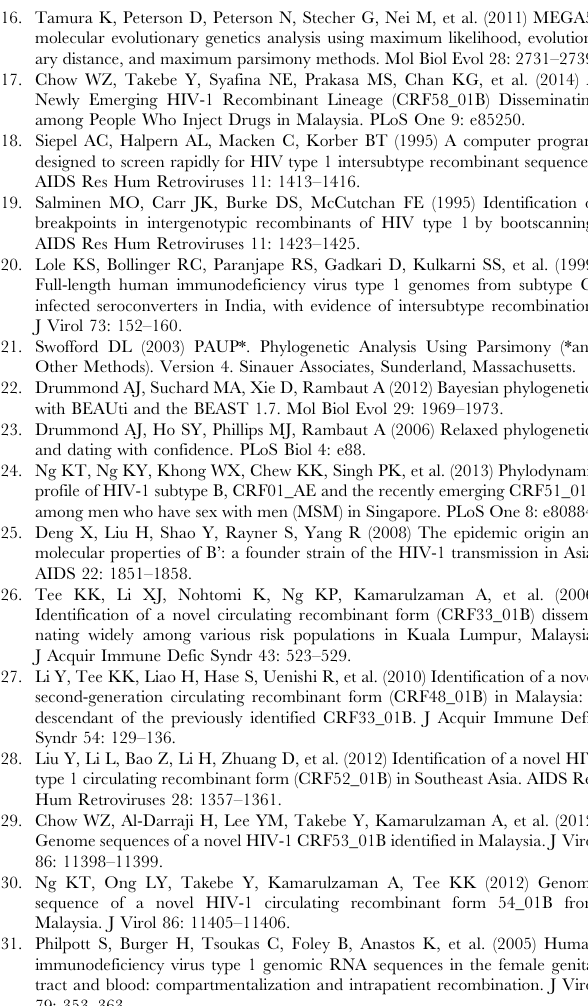
Figure S1 HIV-1 subtype distribution for 485 patients recruited in Kuala Lumpur, Malaysia between year 2008 and 2012. Details are included in in-figure legend. (PDF) Figure S2 Maximum likelihood analysis of the HIV-1 protease, gp120 and gp41 genes of CRF51_01B. CRF51_01B strains from Malaysia are indicated in yellow. (PDF) Figure S3 Maximum clade credibility (MCC) tree reconstructions between CRF51_01B, subtype B and CRF01_AE strains from Malaysia and Singapore in the protease, gp120 and gp41 genomic regions.